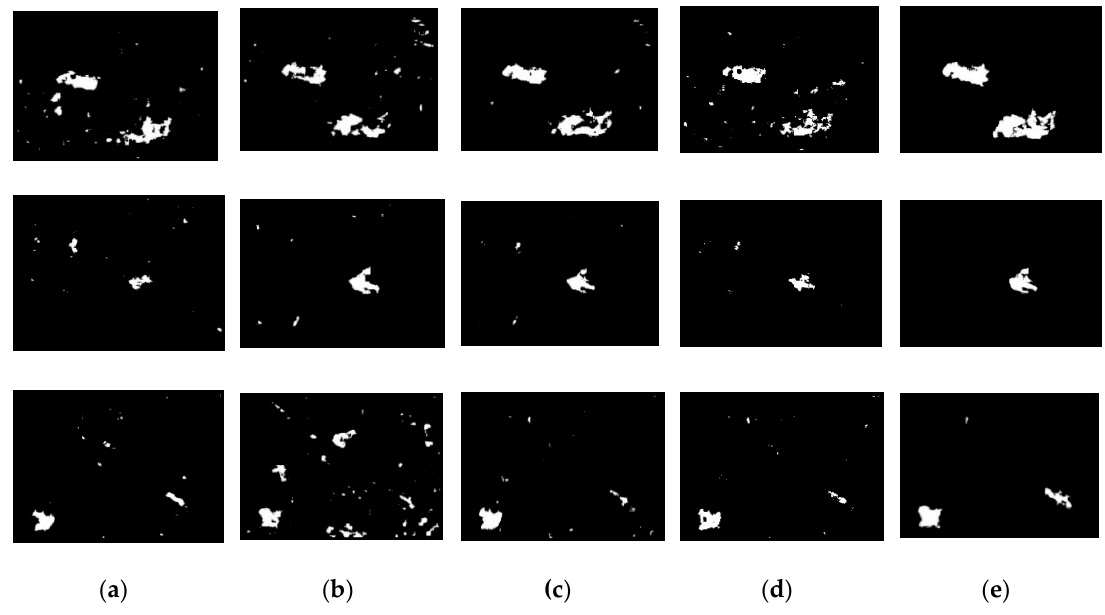
Figure 10. Detection results for three areas when using an individual network output and the proposed algorithms: ( a ) D , ( b ) O , ( c ) Mean, ( d ) SOFN, and ( e ) the proposed fusion network with a